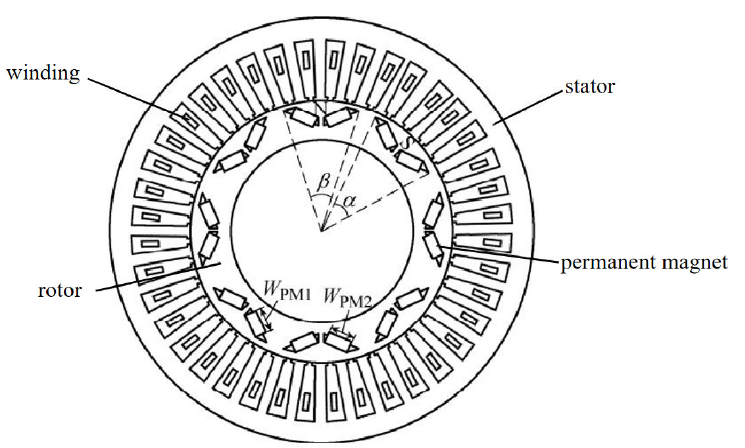
Figure 1. Schematic diagram of IPMSM.